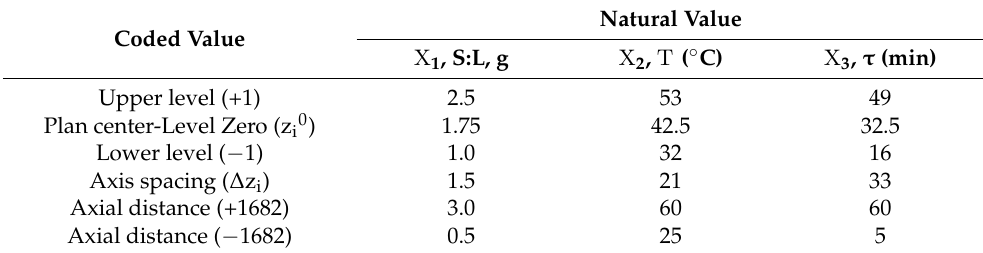
Table 1. Plan center coordinates, variation